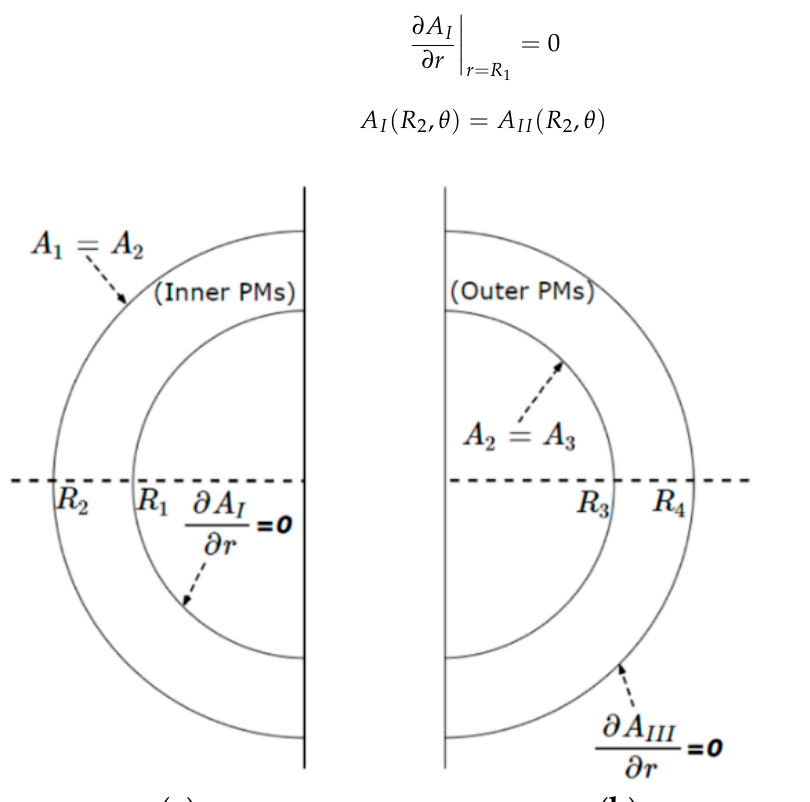
Figure 4. The PM subdomains and their boundary conditions; ( a ) Inner PM region, ( b ) Outer PM region.